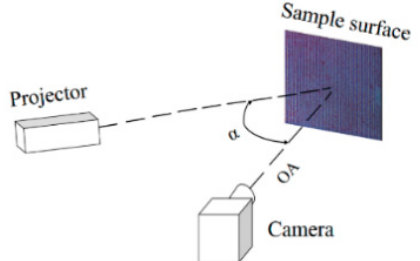
Figure 1. Scheme of FP + 2D-DIC technique.